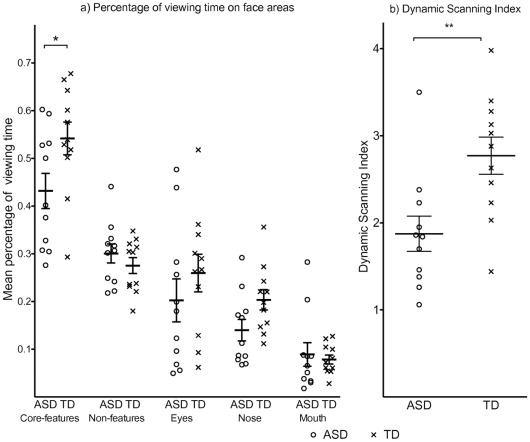
Scatter plots of a) Viewing times on Core-features, Non-core features, Eyes, Nose and Mouth; b) Dynamic Scanning Index, (Horizontal lines indicate group means and standard error means).Difference in group scores: *p<0.05; **p<0.01.